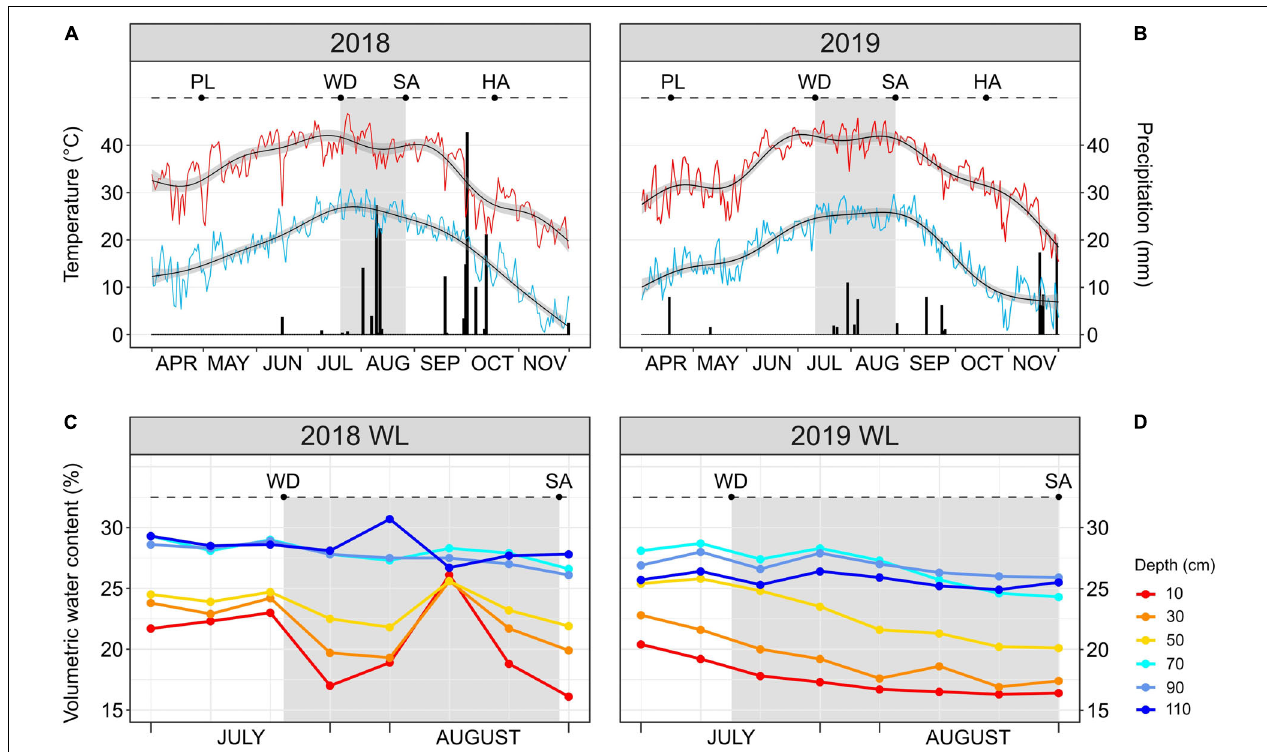
FIGURE 1 | (A,B) Daily maximum (red line) temperature, minimum (light blue line) temperature and precipitation (black bars) during the 2018 and 2019 cotton growing seasons. Smoothed generalized linear models (black lines with gray confidence interval) overlay each temperature curve. (C,D) Soil moisture probe reads at different soil depths (from 10 to 110 cm) for the water-limited (WL) treatment during July–August 2018 and 2019. In every panel, the stress window during which the WL irrigation regime was applied is highlighted in gray. PL, date of planting; WD, date of start of the WL irrigation regime; SA, date of leaf sampling; HA, date of